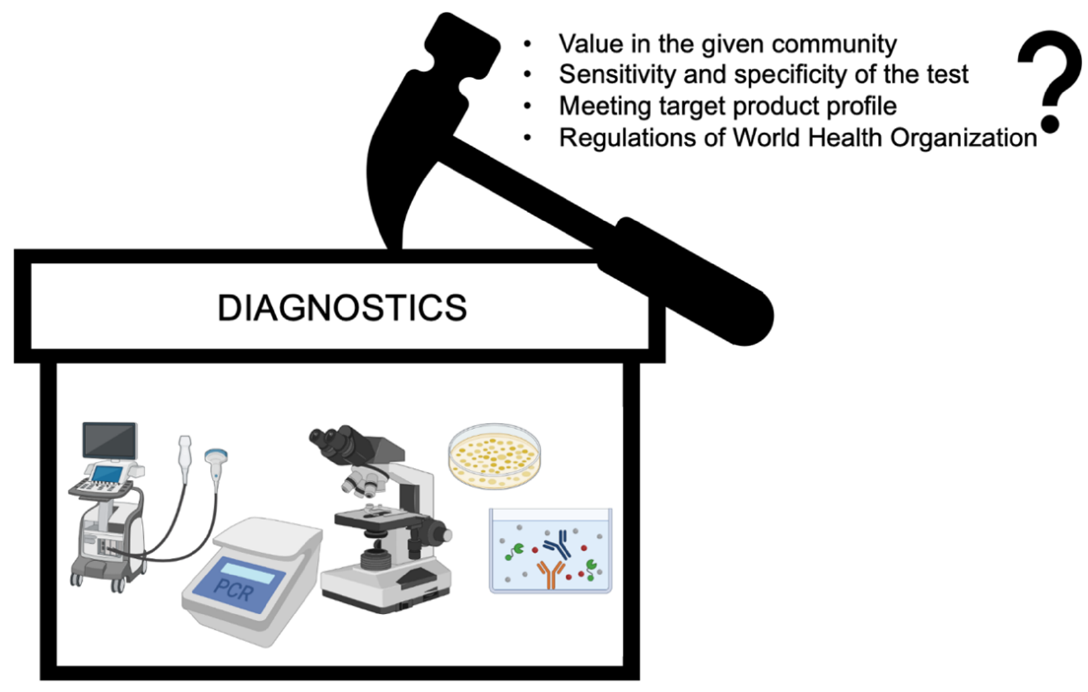
Figure 1. A schematic diagram to demonstrate various restraints in diagnostic techniques. Created using BioRender.com.